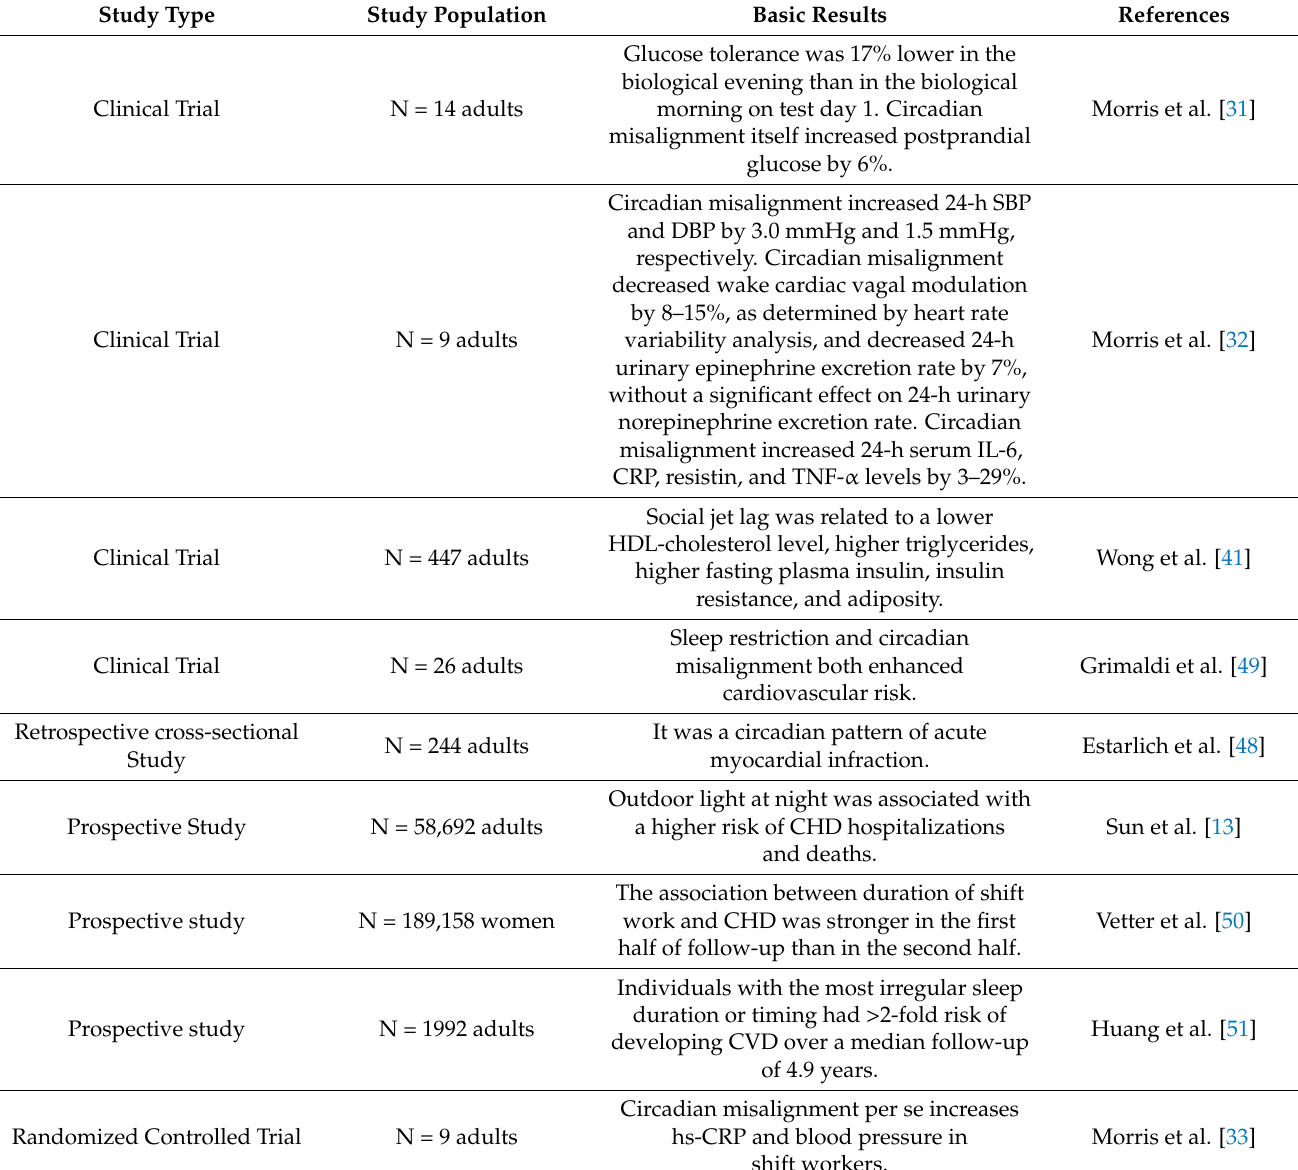
Table 3. Clinical studies analyzing the relationship between circadian rhythms and cardiovascular